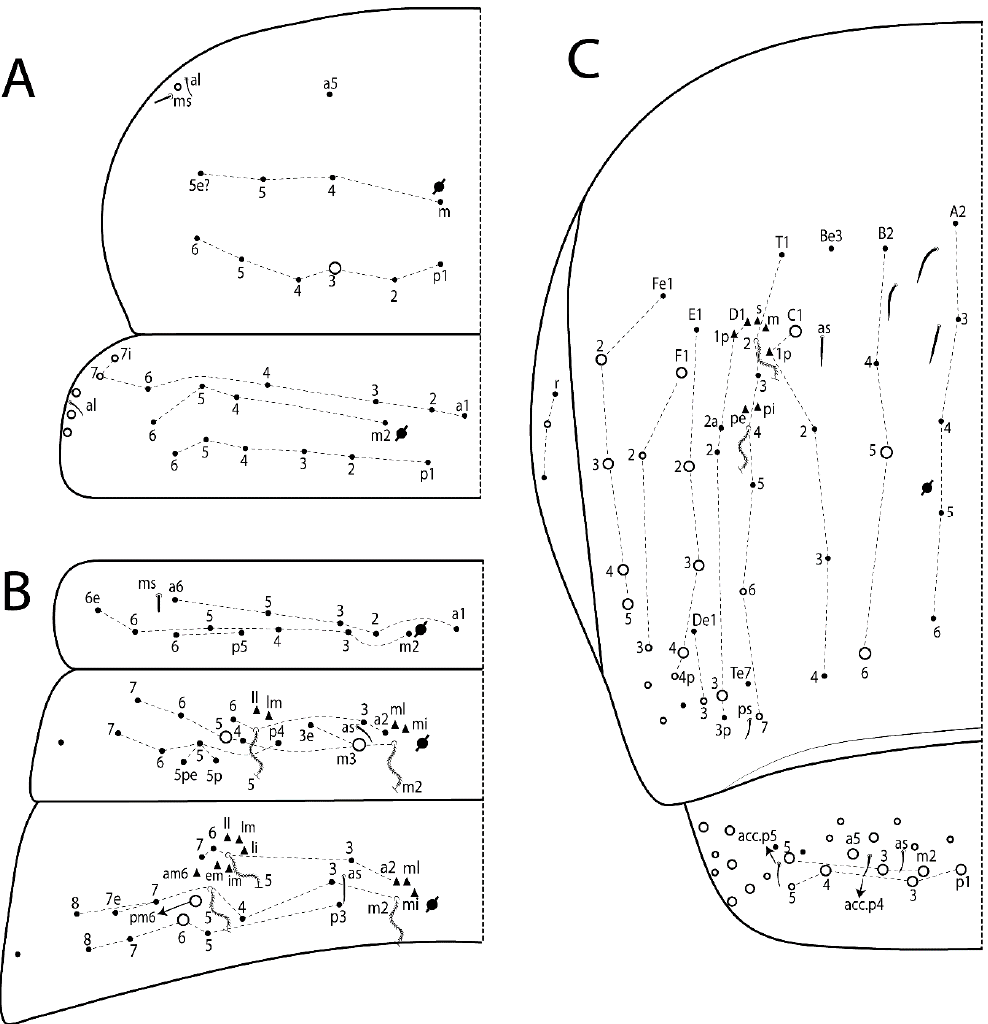
Figure 79. Pseudosinella prelabruscervata sp. nov.: dorsal chaetotaxy. ( A ) Th II–III; ( B ) Abd I–III; ( C ) Abd IV–V.